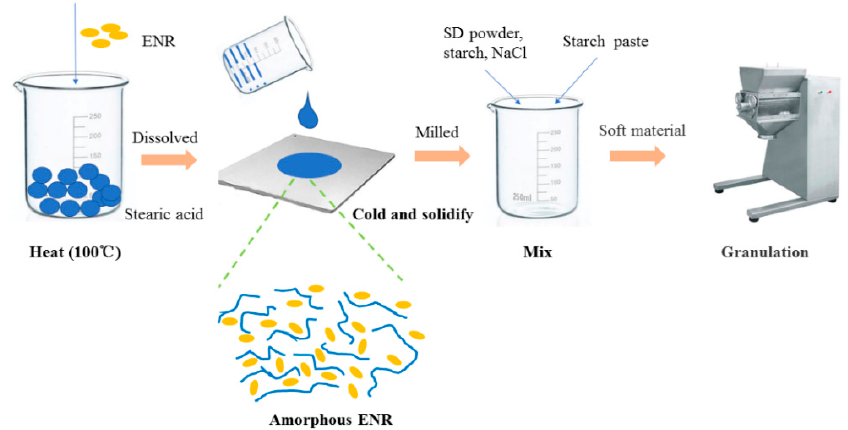
Figure 1. The productive process of the ENR granules.